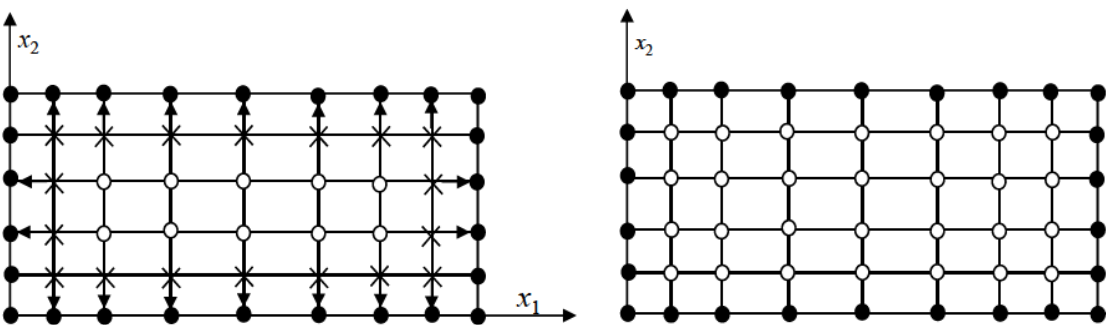
Figure 1: Discretization of the domain in strategy 1